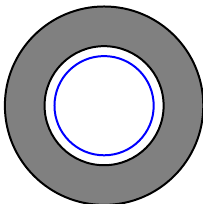
Figure 9 . With the absence of black hole L , bipartitions of the constant time slice of black hole R lead to Z 1 ; 0 ( n(cid:28) ) after gluing. The gray area corresponds to subregion A , and the width of the annulus B will be taken to